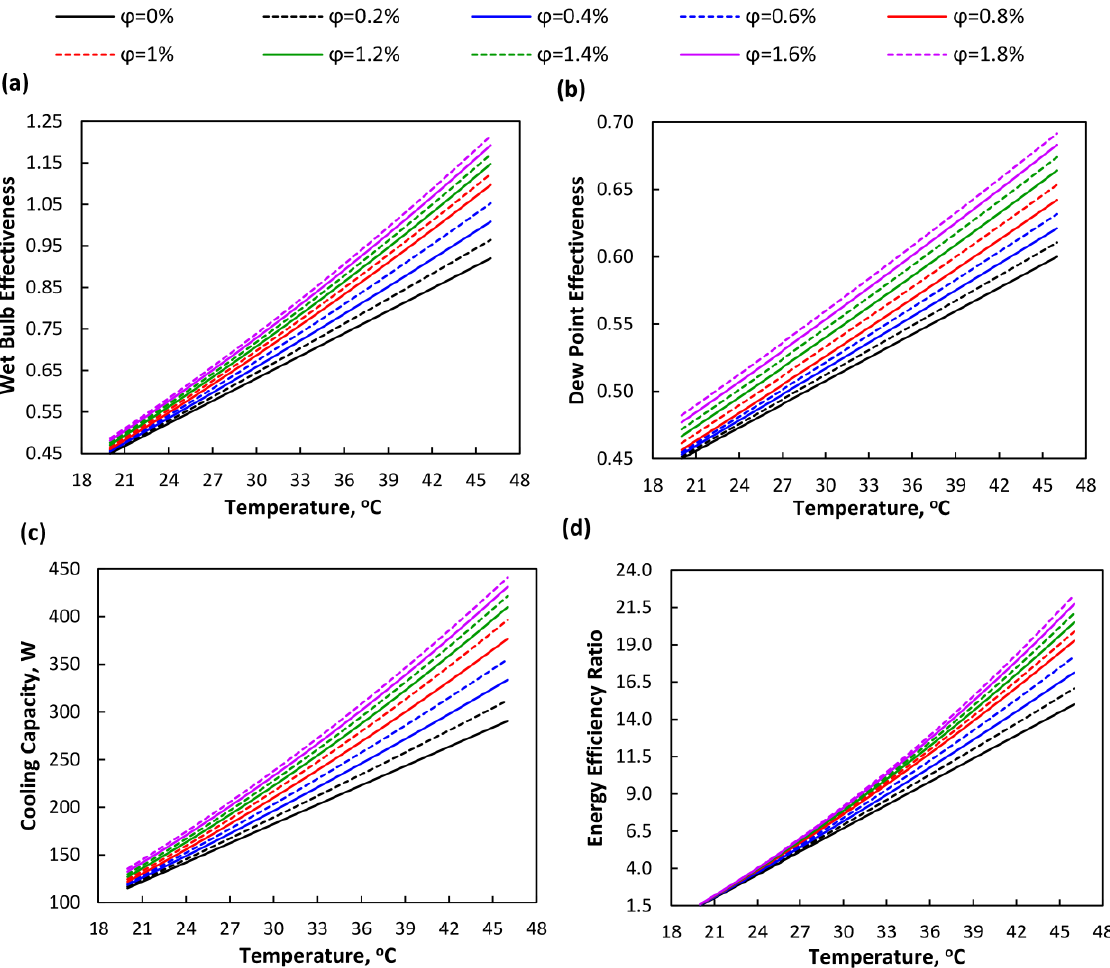
Figure 9. Influence of nanoparticle volume fraction on ( a ) wet bulb effectiveness; ( b ) dew point effectiveness; ( c ) cooling capacity; and ( d ) energy efficiency ratio.